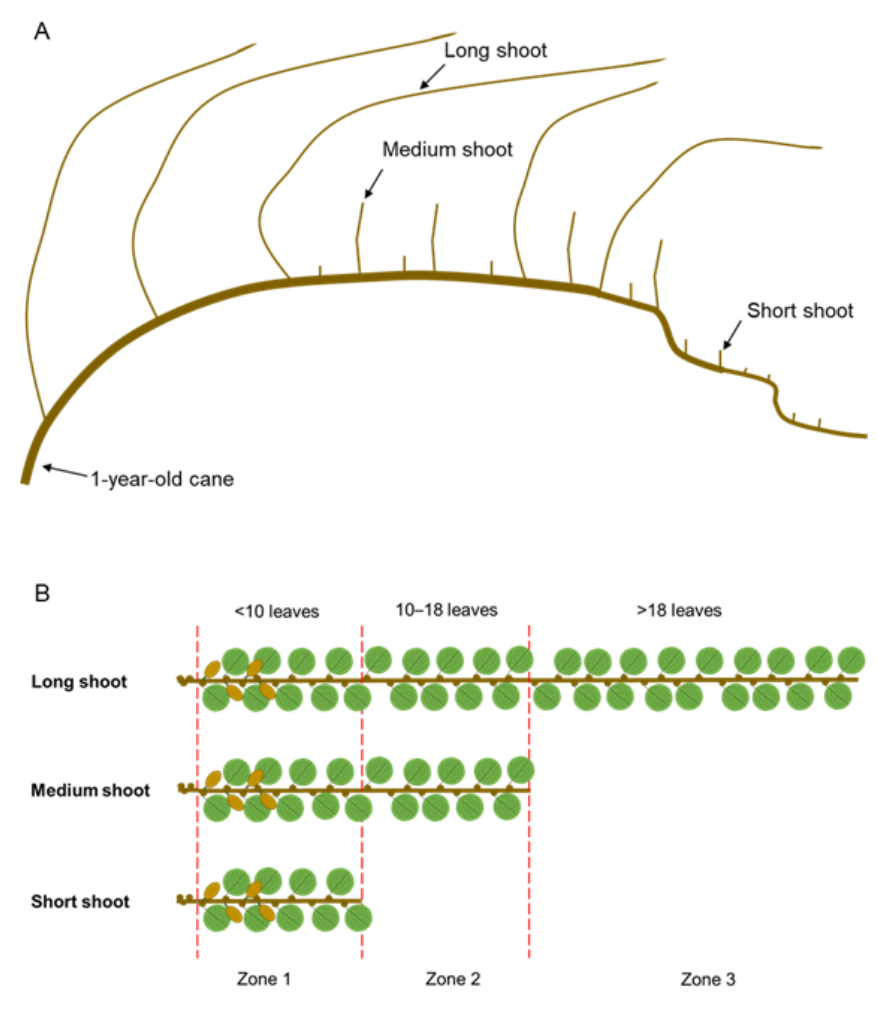
1 Figure 1. Schematic representation of Actinidia spp. branching patterns. ( A ) 1-year-old cane, lignified, with examples of three different shoot types (long, medium and short; redrawn from Seleznyova et al. [41]); ( B ) detailed representation of the three shoot types (new growth from dormant buds, fruiting) and subdivision of the shoots into the Zones according to the number of leaves (based on data from Seleznyova et al.